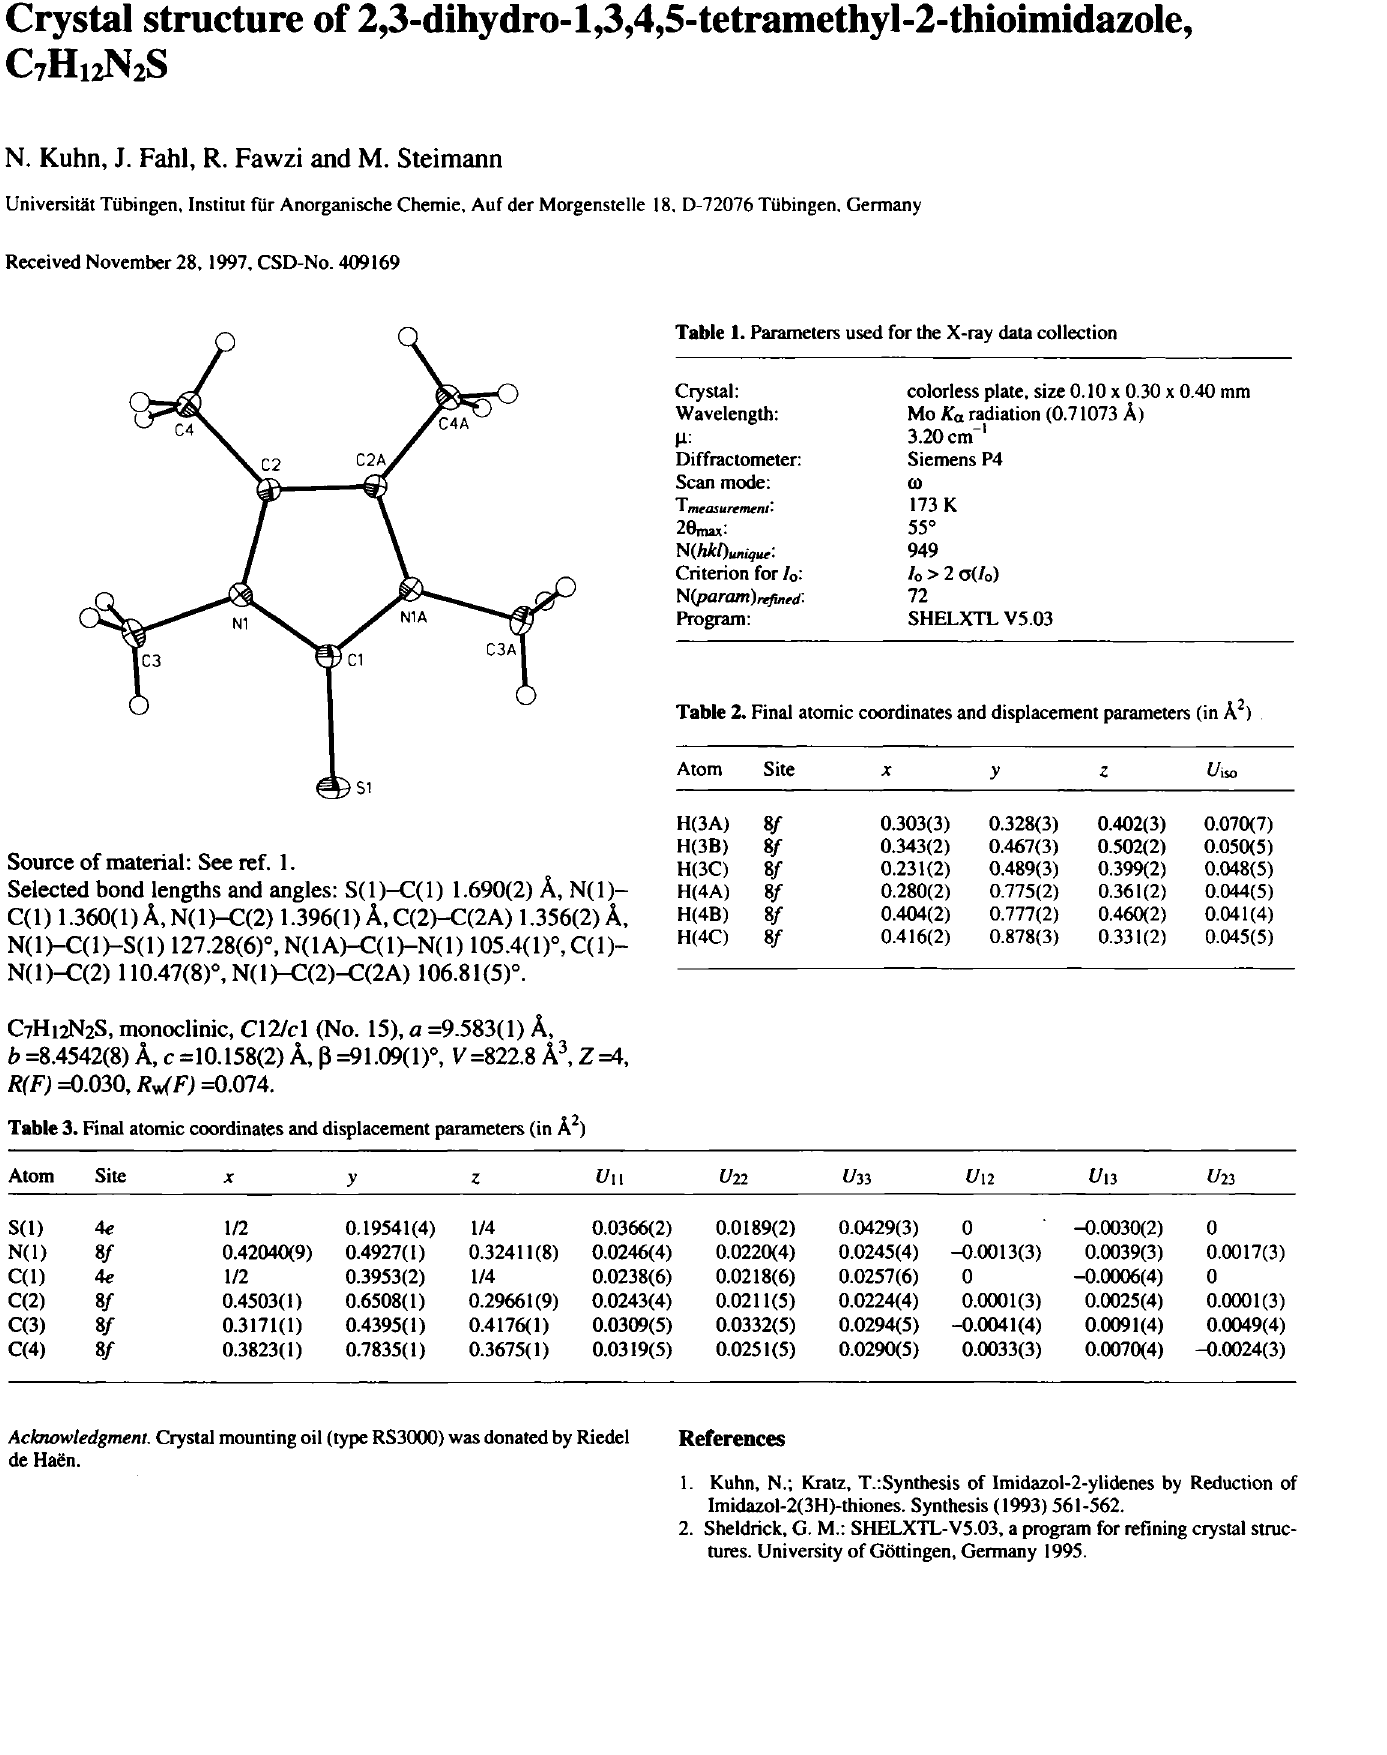
Table 1. Parameters used for the X-ray data collection